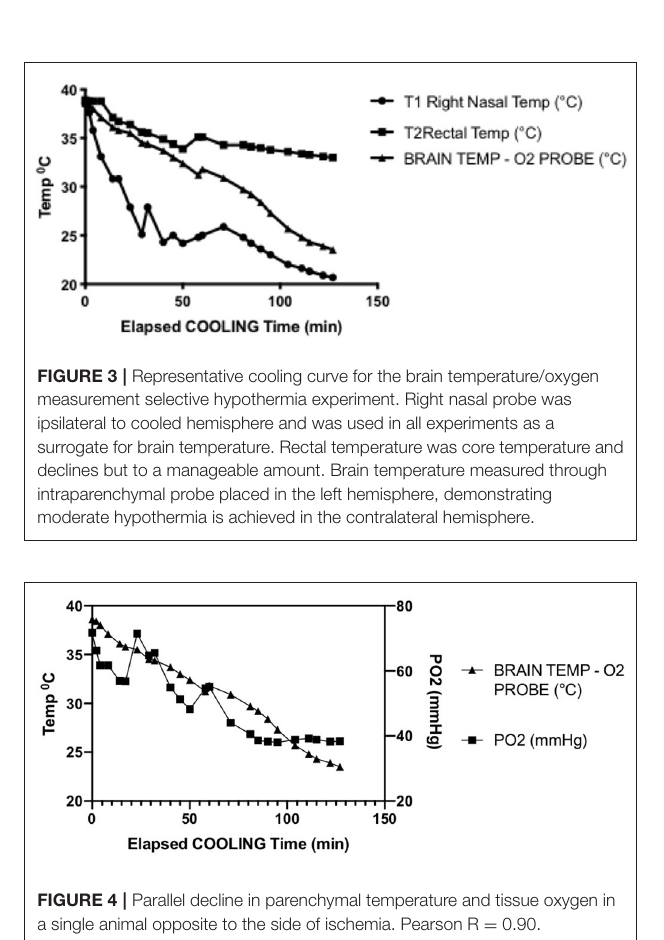
that the longer cooling times have lower ACTs late in